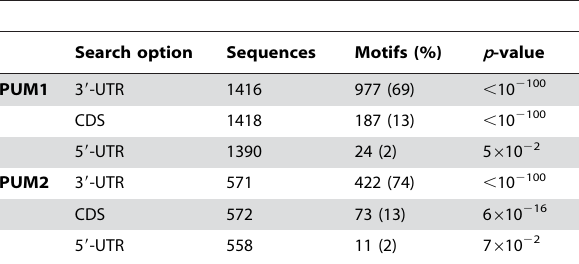
Table 2. Number of PUF consensus motifs found in human PUMILIO targets (FDR , 5%).